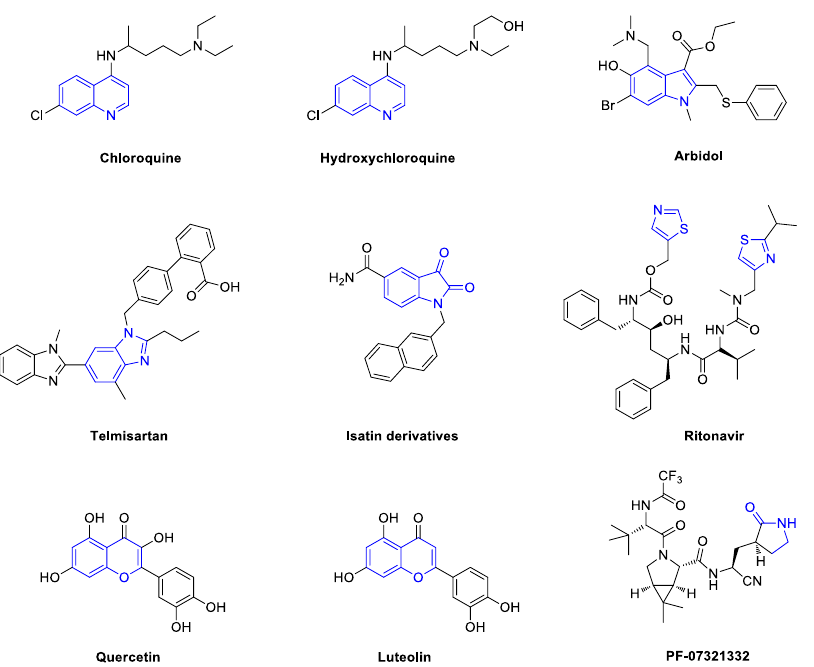
Figure 1. Heterocyclic drugs showing promising activity against SARS-CoV-2 [13 – 18]. Heterocyclic compounds have versatile applications across many chemistry fields.